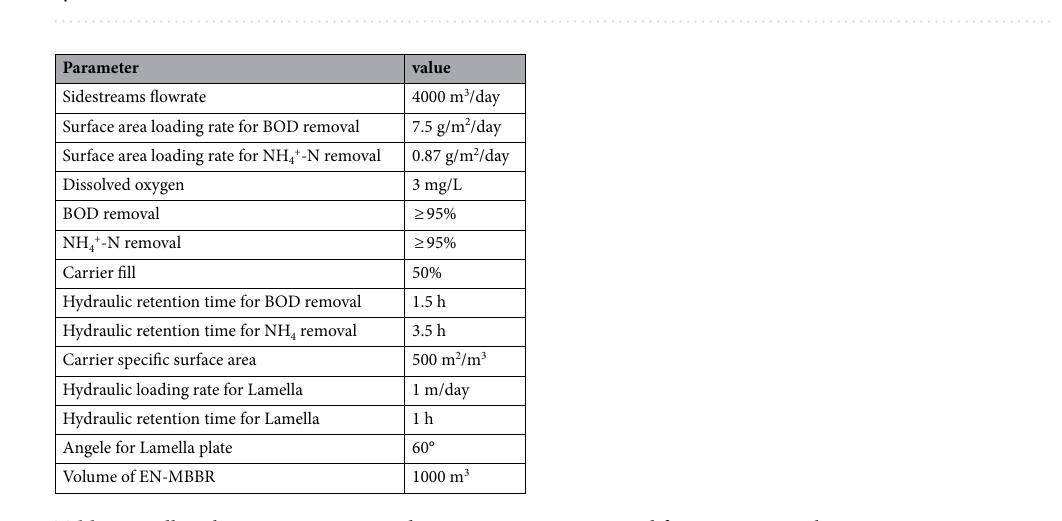
Figure 4. Proposed schematic diagram of the A 2 /O system and the novel process development of EN-MBBR system.